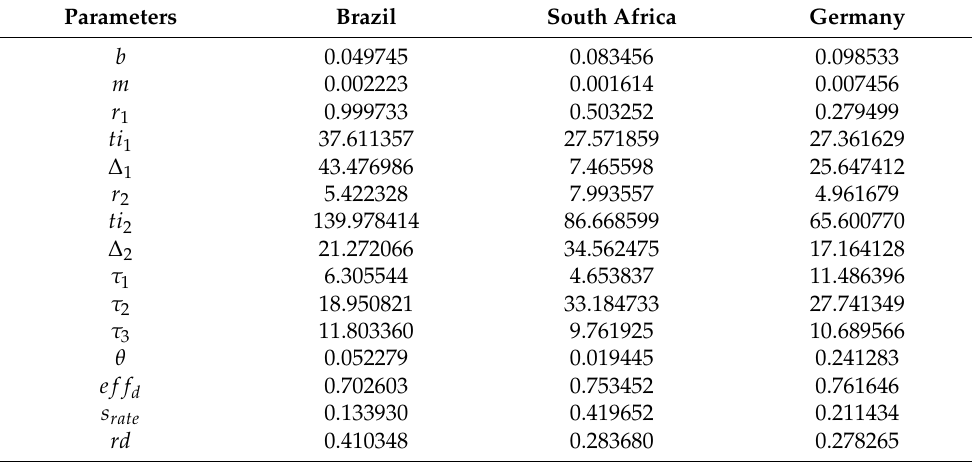
Table 1. Characterisation of the COVID-19 pandemics by the best parameter values by country: b represents the basic infection rate, m , the mortality rate previous to Omicron; r 1 , the contact reduction factor; t i , the start time for intervention policy 1; ∆ 1 , the intervention policy duration; r 2 , 1 Omicron transmission rate factor; t i , the start time for the Omicron variant; ∆ 2 , the transition to 2 Omicron duration; τ 1 , the incubation period; τ 2 , the time from symptoms to death; τ 3 , the time from symptoms to recovery; θ is the notified cases; ef f d is the vaccine efficacy for prevent deaths; s rate is the potential of reinfection; rd is the mortality reduction factor during Omicron. Parameters Brazil South Africa